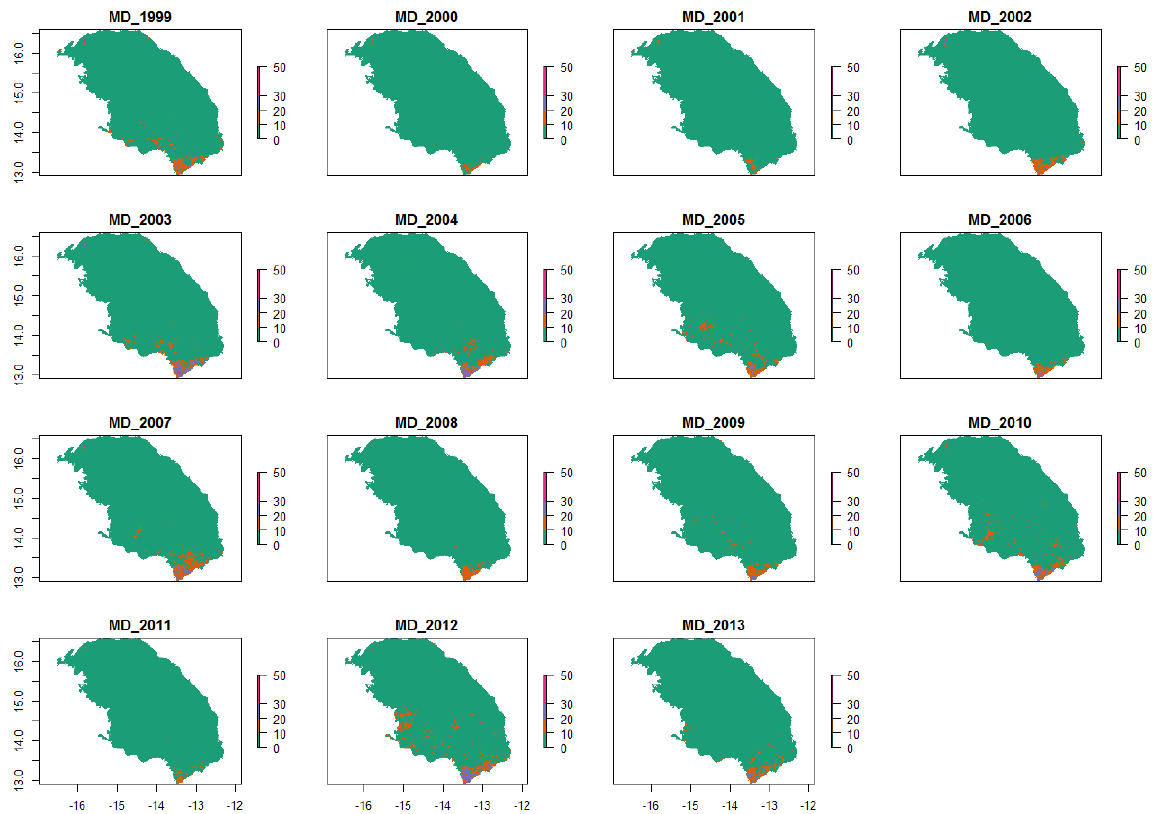
Figure A1. Spatial distribution of percentage of missing data (MD) in yearly FAPAR time series from 1999 to